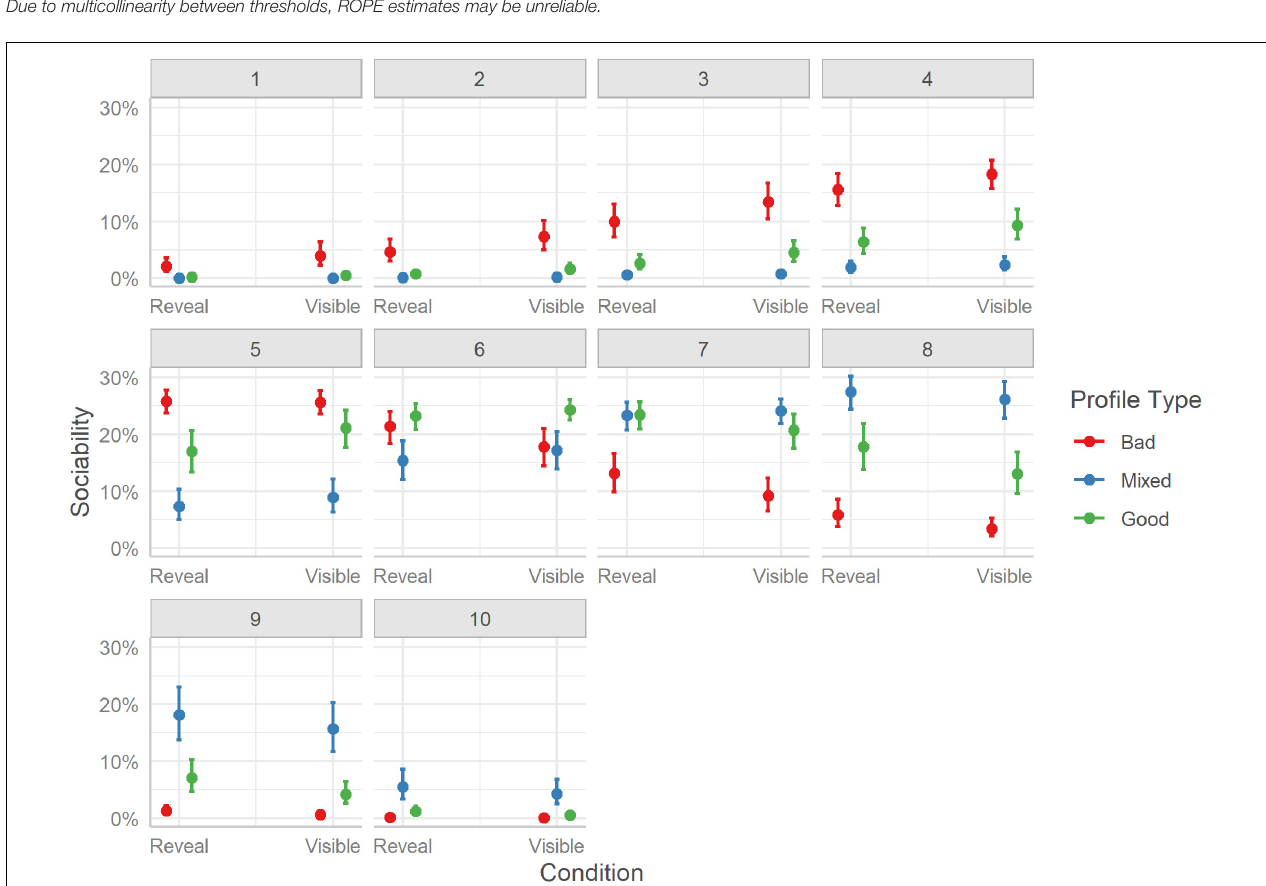
FIGURE 6 | Marginal effects of sociability. The posterior mean estimates of the probability of responses in each of the three Profiles (Bad, Good, Mixed) by the two experimental Conditions (Reveal or Visible). Error bars indicate 95% credible